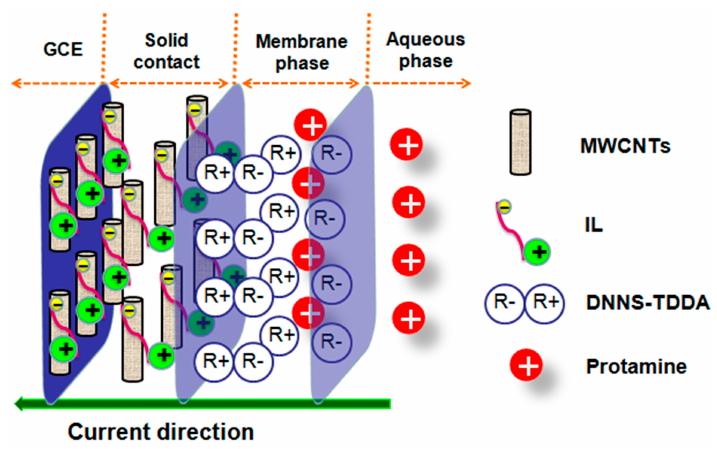
Figure 2. Schematic diagram of the polycation-sensitive electrode based on a MWCNT-IL composite as a solid contact for the chronopotentiometric detection of protamine.